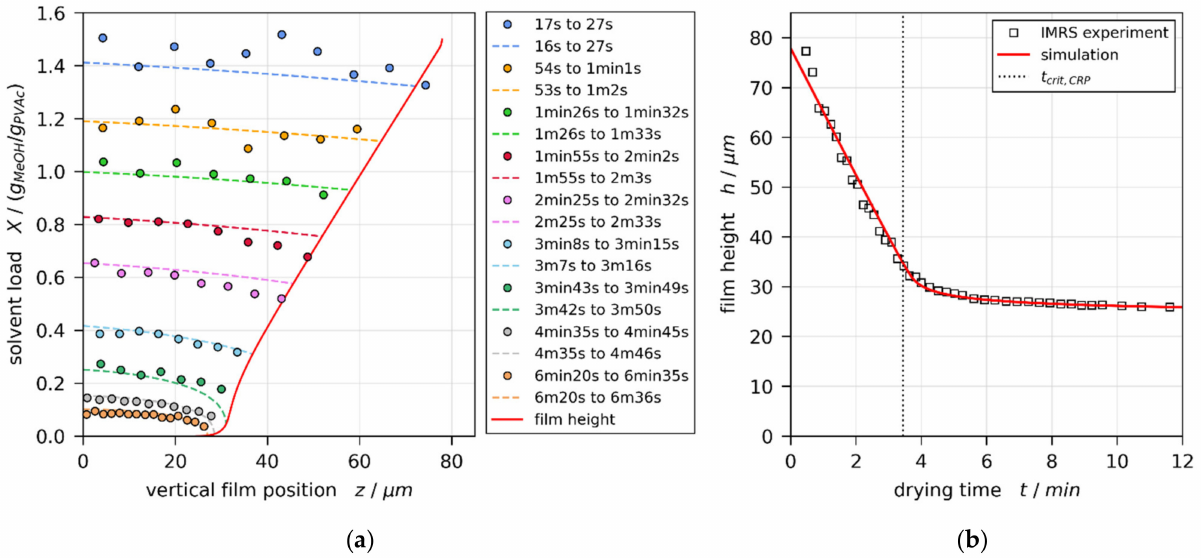
Figure 4. Comparison of experimental IMRS and best-matching simulation results for a drying poly (vinyl acetate)- methanol film ( X 0 = 1.5 g /g and h gap = 200 µ m, initially convectively unstable until t crit , Ma = 2.4 min MeOH PVAc according to Reference [1]), drying at T substrate = 20 ◦ C and otherwise ambient conditions. The simulation was per- formed with experimental dry-film thickness and initial solvent load, as well as an effective upper heat-transfer coefficient (cid:0) (cid:1) α top = 1.5 W/ m 2 · K . ( a ) Vertical solvent-load profiles at different drying times. Since IMRS is a scanning method, the acquisition time is given in ranges. This has been accounted for in the simulation. ( b ) Transient film height (drying curve) and end of constant rate period t crit , CRP